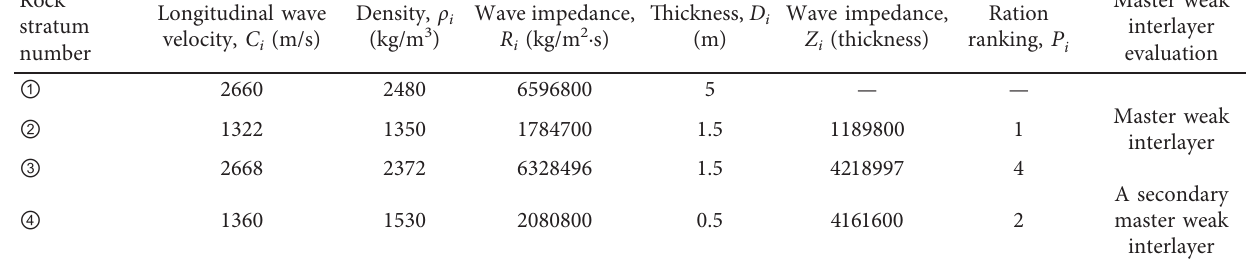
Table 9: Evaluation calculation of the master weak interlayer.